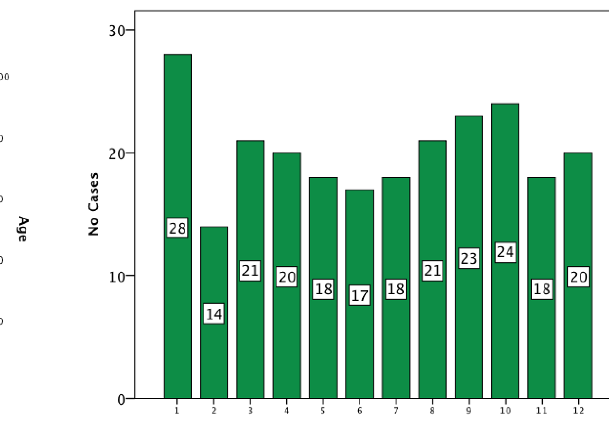
Figure 1. Case distribution on sex and age Figure 2. Cases distribution on